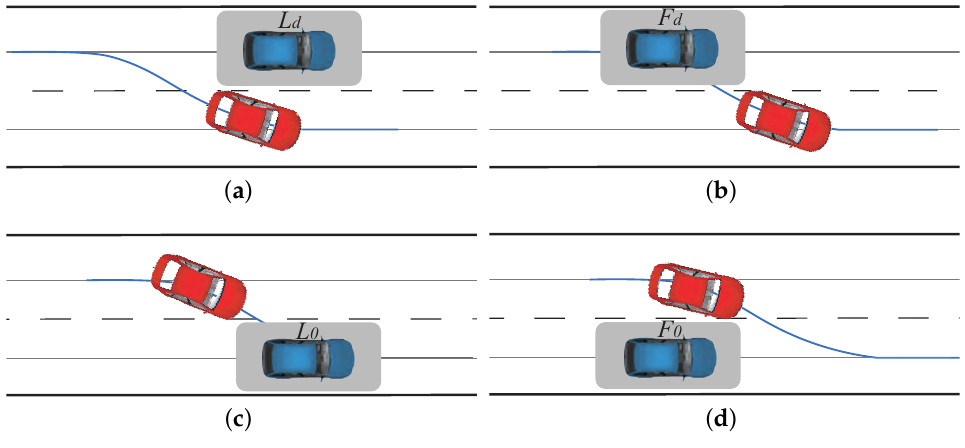
Figure 9. The defined critical lateral position for a right lane-change scenario. ( a ) The lateral position for vehicle L d at t c , Ld . ( b ) The lateral position for vehicle F d at t c , Fd . ( c ) The lateral position for vehicle L 0 at t c , L 0 . ( d ) The lateral position for vehicle F 0 at t c , F 0 . The minimum longitudinal safe distances for lane-change abortion are as